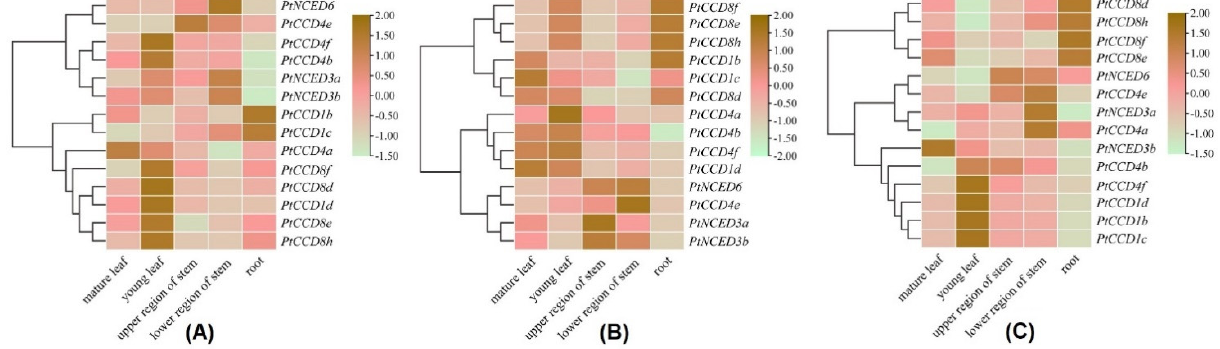
Figure 7. The qRT-PCR analysis of PtCCDs expression patterns in different tissues of poplar varieties including P. trichocarpa ( A ), ‘Nanlin 895’ ( B ), and ‘Shanxinyang’ ( C ). The gene expression levels in mature and young leaves, upper and lower regions of stems and roots were identified using qRT-PCR. Three independent experiments were performed. The data are normalized to poplar Ptactin (XM-006370951). PtCCD transcript levels were normalized to that in mature leaves; color scale, log2-fold change.